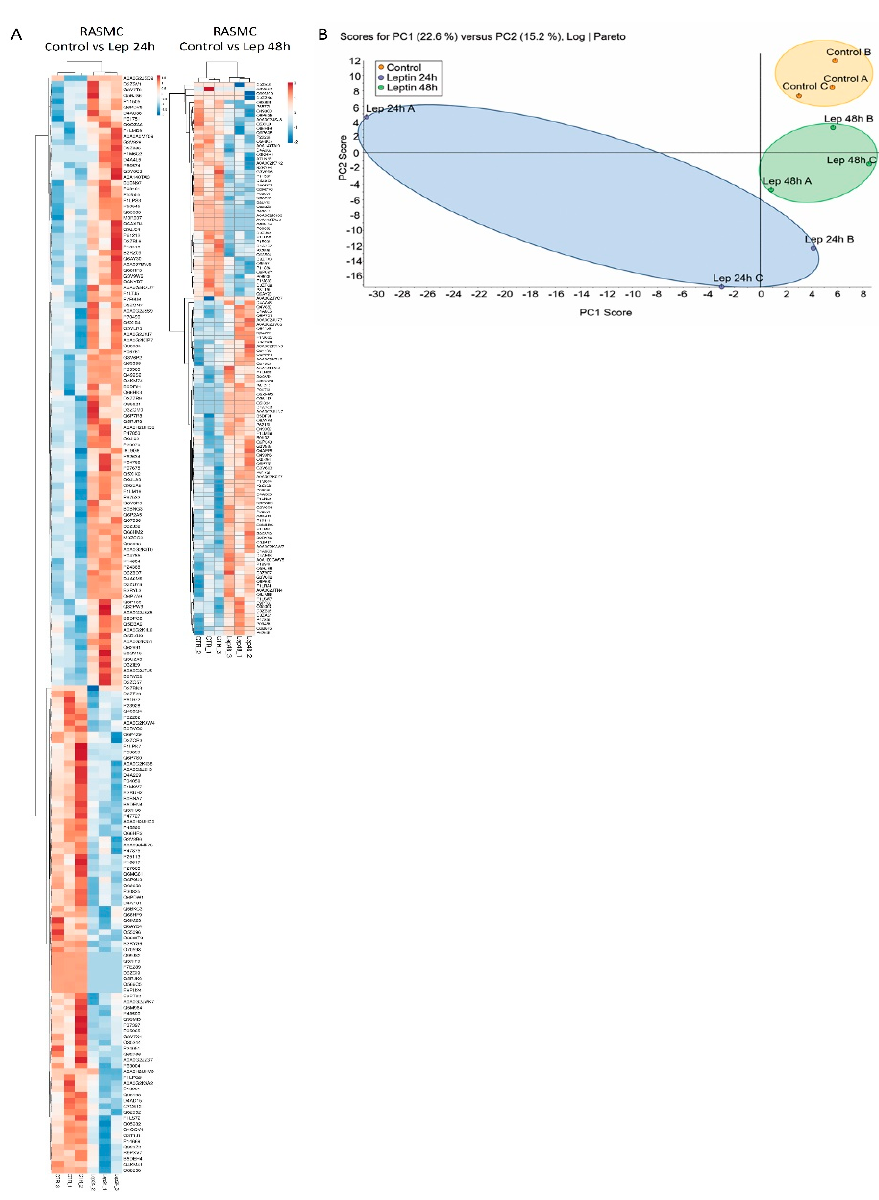
Figure 5. Characteristics of proteomic of leptin-stimulated RASMC. ( A ) . Hierarchical clustering (heat maps) of protein expression profiles in the leptin- (24 h or 48 h) stimulated RASMC compared to control. The downregulated proteins are represented in blue, whereas the upregulated proteins are represented in red. The level of the protein regulation is reflected in the color intensity and the accession numbers of the proteins are listed to the right side of the heat maps. The dendrogram shows the clustering of the proteins and the samples with each other. ( B ) . Principal component analysis (PCA) of the leptin-stimulated RASMC samples. The axis of the principal components is depicted according to the protein expression. The control samples are enclosed by the yellow oval, the leptin 24 h stimulated samples are enclosed by the blue oval, and the leptin 48 h stimulated samples are enclosed by the green